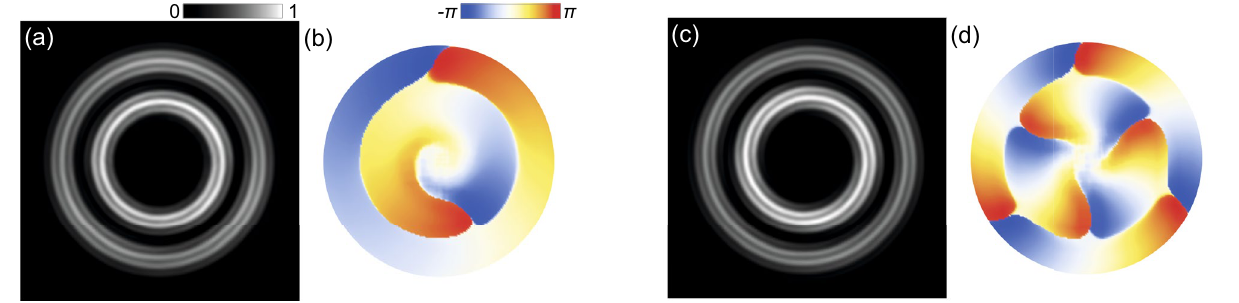
Figure 4. Simulated concentric ring polariton condensates with azimuthal currents. Panels ( a , c ) show interferometry images obtained by simulating interference of the polariton condensates with the spherical reference wave. Panels ( b , d ) show the corresponding spatial distribution of phases of the simulated condensates. 1 for ( a , b ) and m 3 for ( c , d ). Details of the model and values of the parameters Topological charge is m = = used for simulations are given in